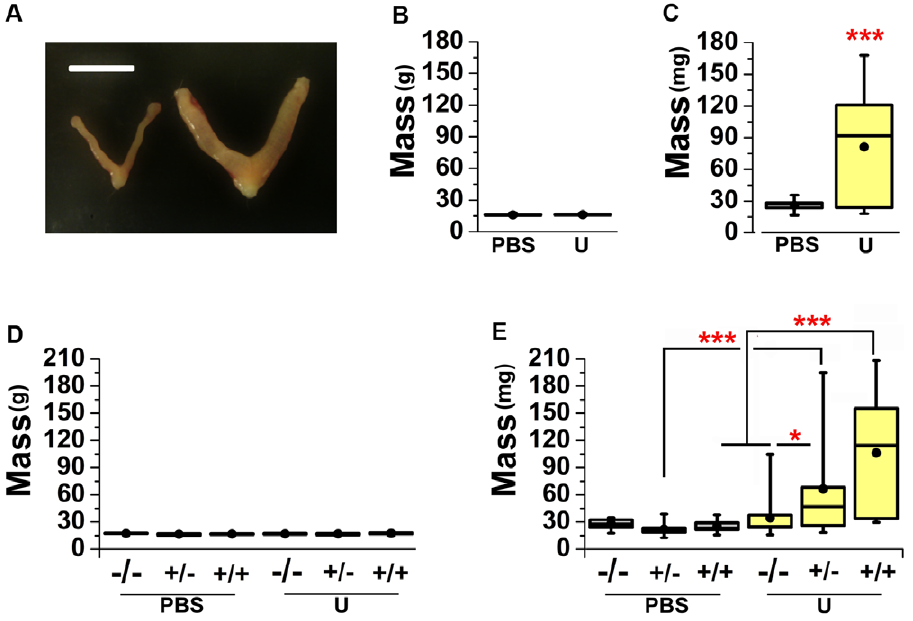
Figure 1. Male urinary pheromones alter female reproductive physiology. ( A ) Six-day exposure to male urine increases uterine mass, an indirect assay for puberty acceleration. Left; dissected uterus from a PBS-exposed female, right; dissected uterus from a female exposed to male urine. Scale bar, 1 cm. ( B ) Urine pheromones do not increase total body mass (t-test, p=0.441). n=13 per group. ( C ) Exposure to male urine results in an increase in uterine mass (t-test). n=13 per group. ( D ) Urine pheromones and TrpC2 genotype have no significant effect on body mass (p=.132). n=9–16 per group. ( E ) Exposure of TrpC2-/- females to male urine does not result in an increase in uterine mass (Tukey’s HSD). n=9–16 per group. PBS; phosphate buffered saline, U; male urine. (see Methods for explanation of box and whisker plot representation). *p , 0.05, ***p , 0.001.